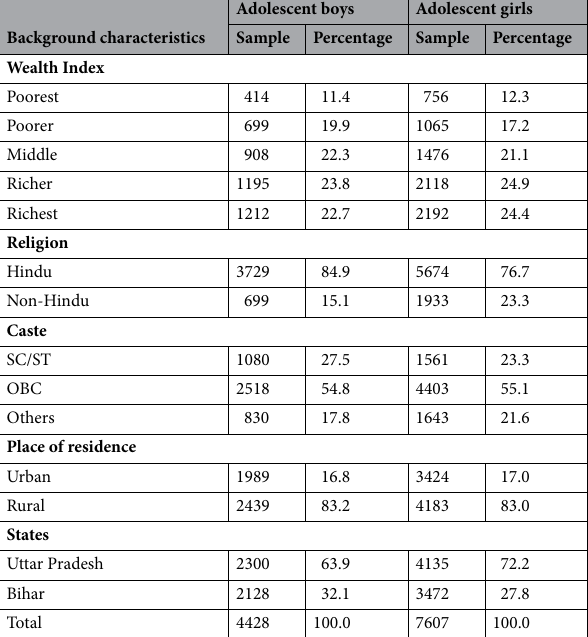
Table 1. Socio-economic characteristics of study population, 2015–2016. SC/ST: Scheduled Caste/Scheduled Tribe; OBC: Other Backward Class.